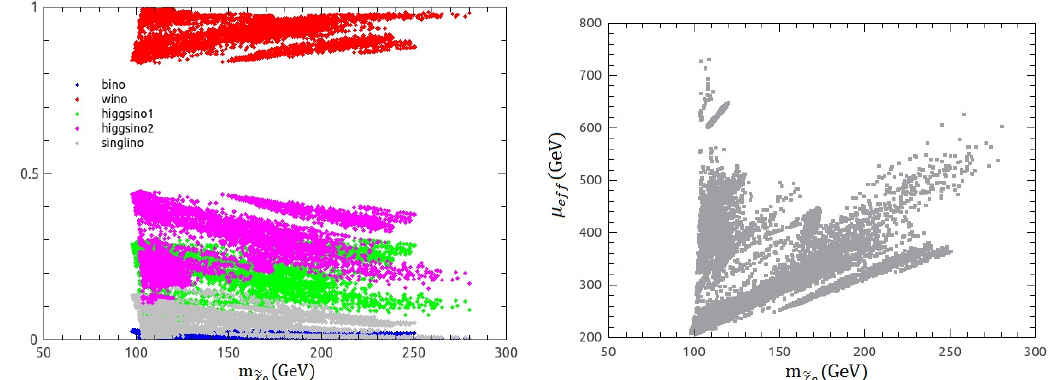
Figure 6 . The left plot shows the matrix elements to diagonalize the neutralino mass matrix N 1 i versus the lightest neutralino mass( m ) while the right plot shows the e(cid:11)ective (cid:22) parameter for ~ (cid:31) 1 0 higgsino mass (cid:22) e(cid:11) (cid:17) (cid:21) h s i versus the lightest neutralino mass( m ). All survived points satisfy the ~ (cid:31) 1 0 LHC and EW precision measurement constraints as well as the required value of (cid:1) a (cid:22) . scale. The gaugino mass ratios at the weak scale are given approximately